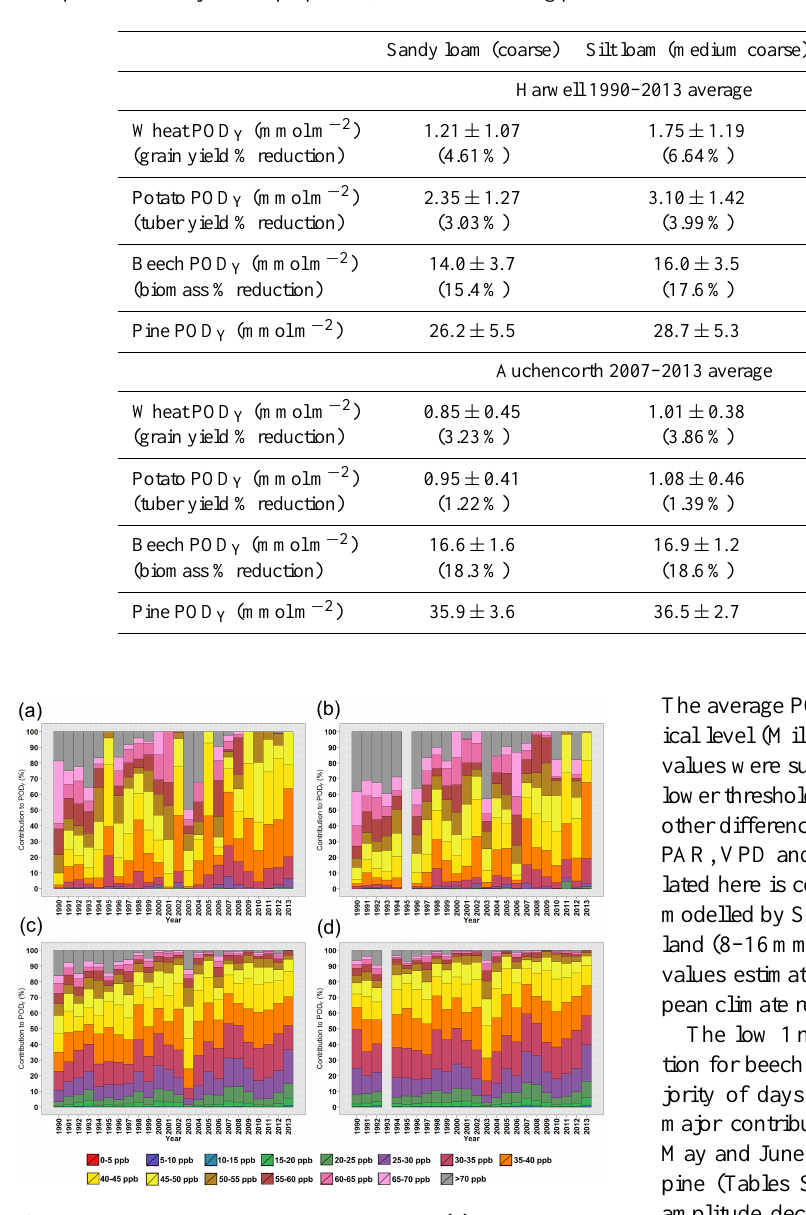
Figure 10. Relative annual contributions to (a) wheat POD Y , (b) potato POD Y , (c) beech POD Y and (d) Scots pine POD Y at Harwell from different O 3 concentration bins. Concentrations are separated into 15 5ppb groups spanning hourly O 3 concentrations between 0ppb and >70ppb. Note: these concentration bins are con- tributing to constant trends in POD Y for each vegetation type – see Fig.